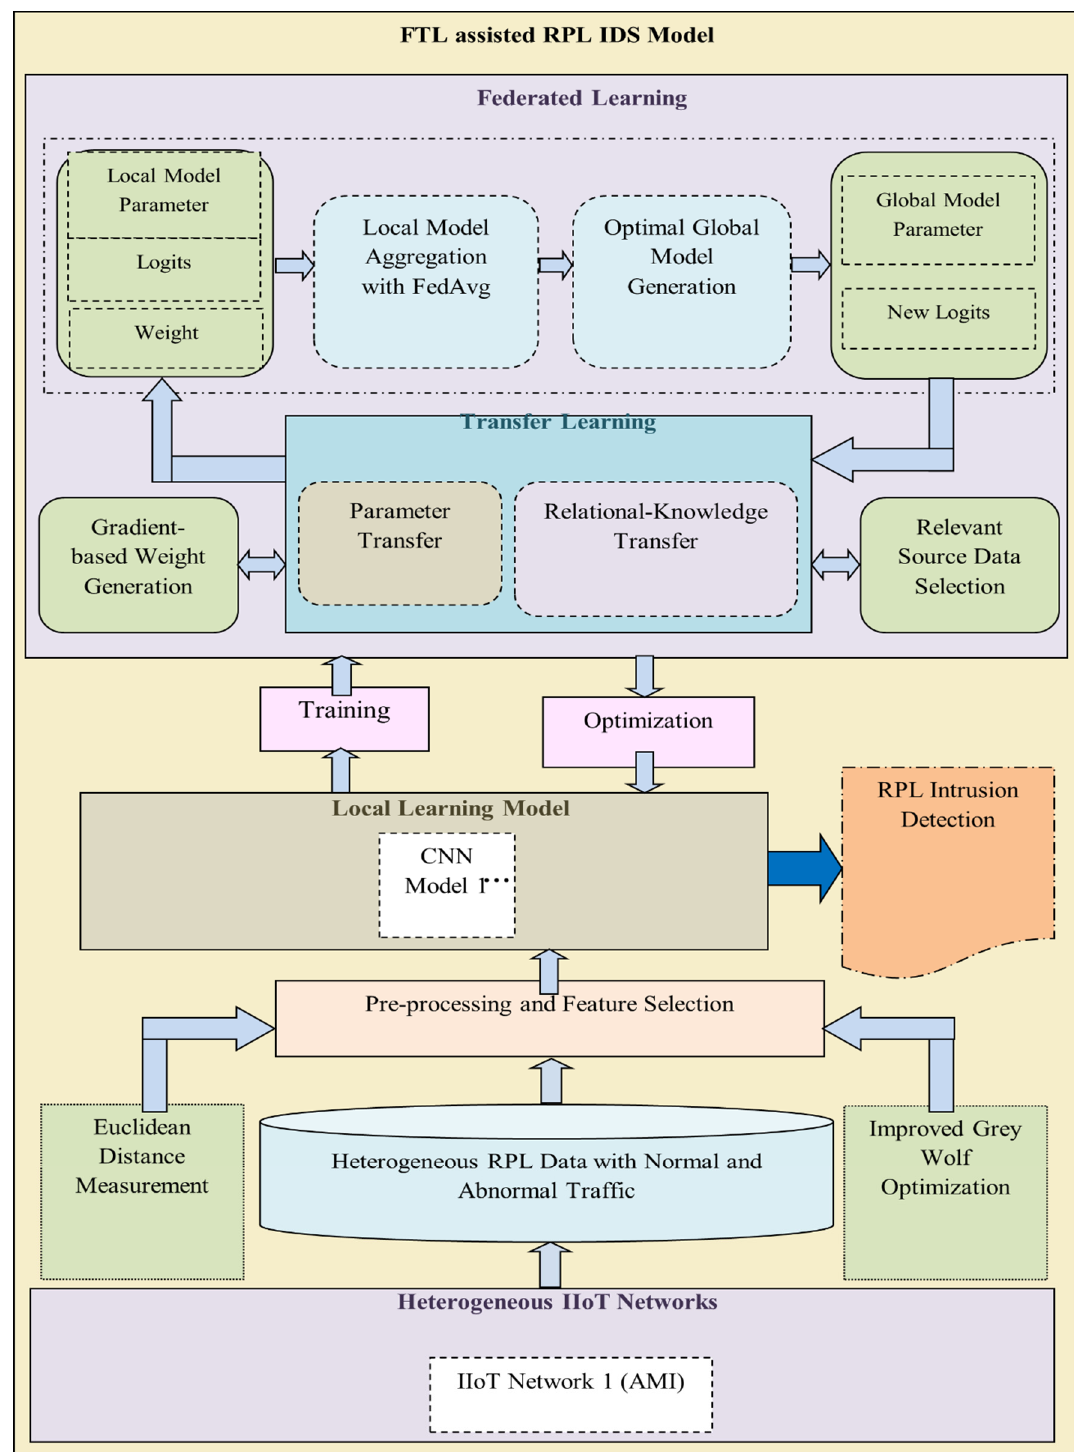
Figure 3. Process flow of the proposed FT-CID model.